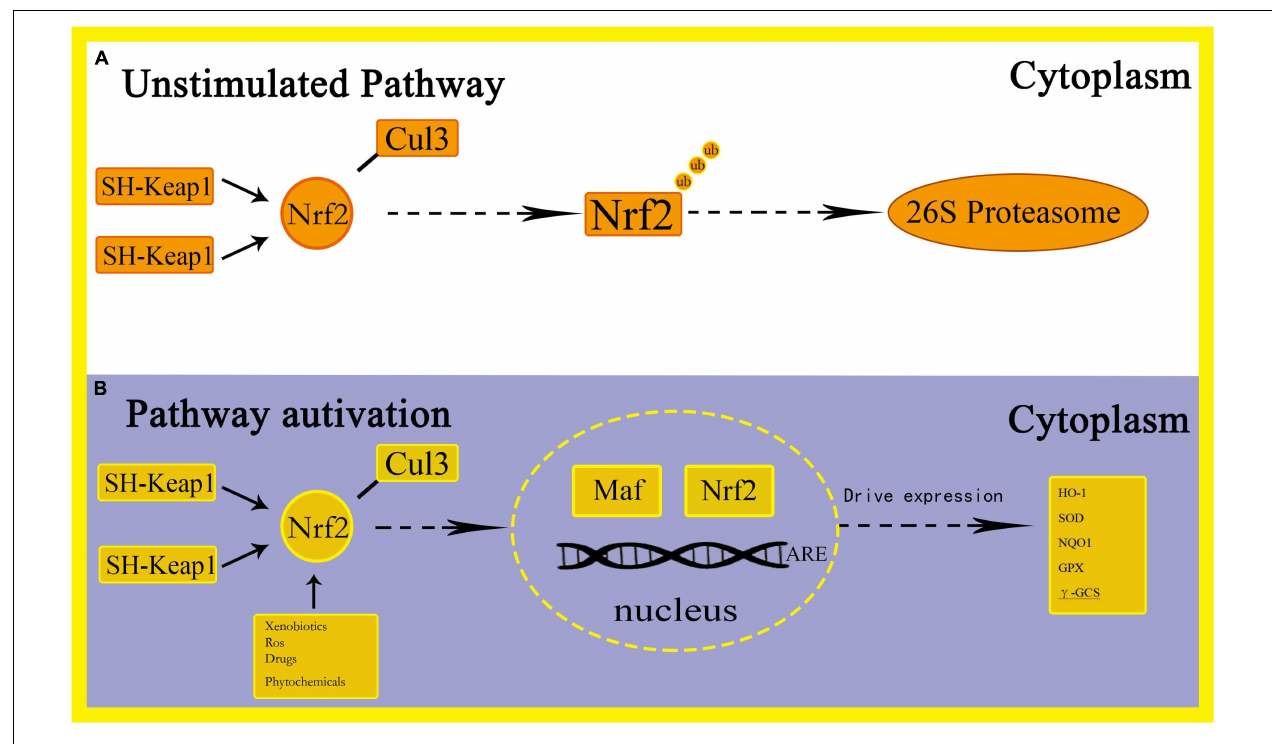
FIGURE 2 | Schematic representation of Nrf2-ARE activation